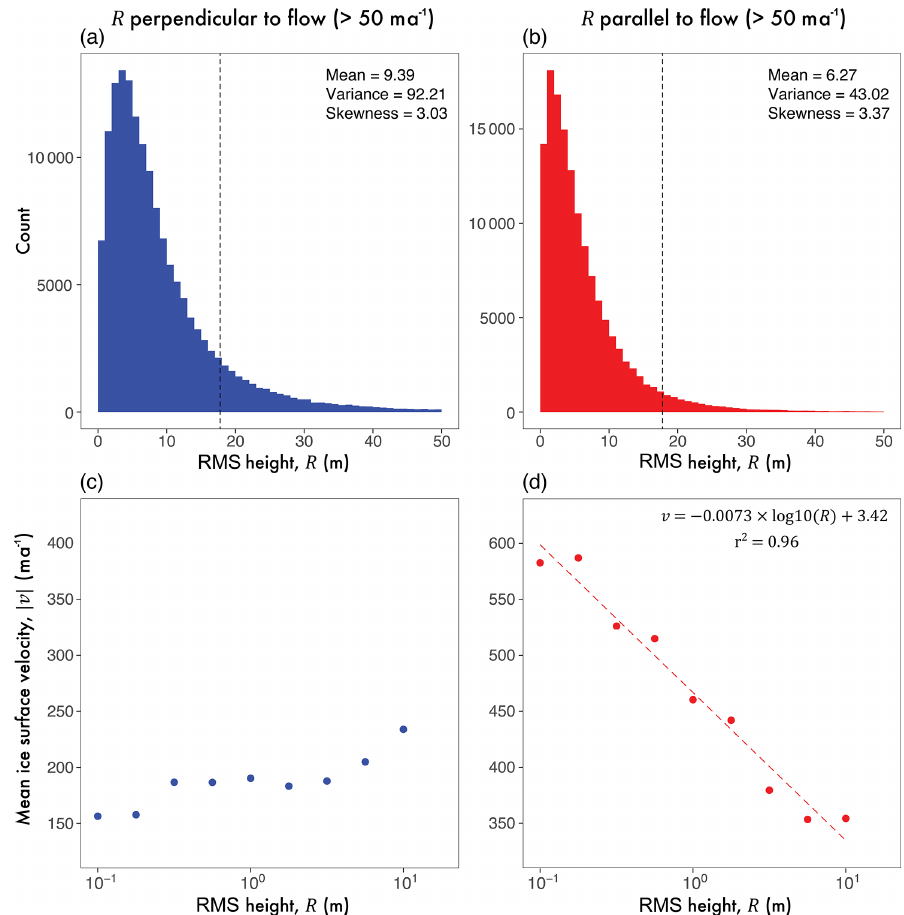
Figure 7. Relationship between R ⊥ and R (cid:107) and surface ice velocity for fast-flowing ( | v | > 50ma − 1 ) regions of the GrIS. (a) and (b) present distributions R ⊥ and R (cid:107) , respectively. (c) and (d) show mean ice surface speed, | v | , calculations for logarithmic R bins (at 0.25m intervals). This is a linear–log plot, where the limit of the horizontal axis ( R ) is 10 1 . 25 m, noted by the dashed black lines in (a) and (b) . It should be noted that the vertical exaggeration of these two plots is constant. Mean values for ice surface speed are used here to facilitate direct comparability to previous work presented in Lindbäck and Pettersson (2015). Colours here are consistent with Fig. 3c for alignment with surface flow